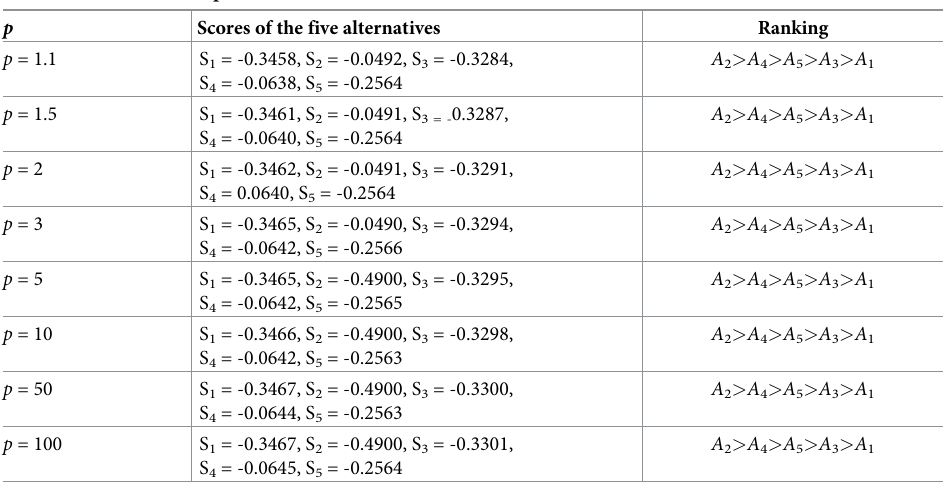
Table 7. The results of experiment 2.